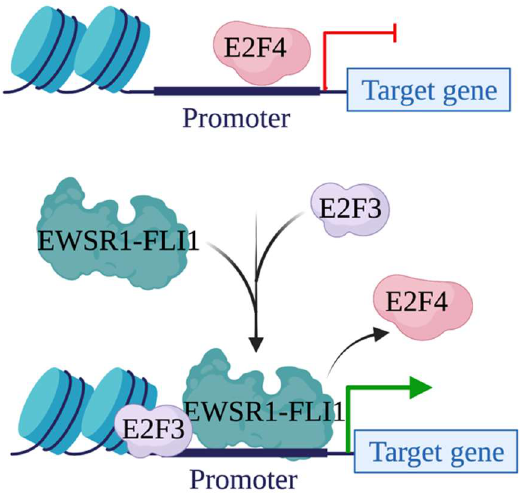
Figure 3. EWSR1-FLI1 employs an E2F switch to drive target gene expression. In the absence of EWSR1-FLI1, E2F4 binds to chromatin to repress gene expression. In the presence of EWSR1-FLI1, E2F3 displaces E2F4 and recruits EWSR1-FLI1 on chromatin to initiate gene transcription.